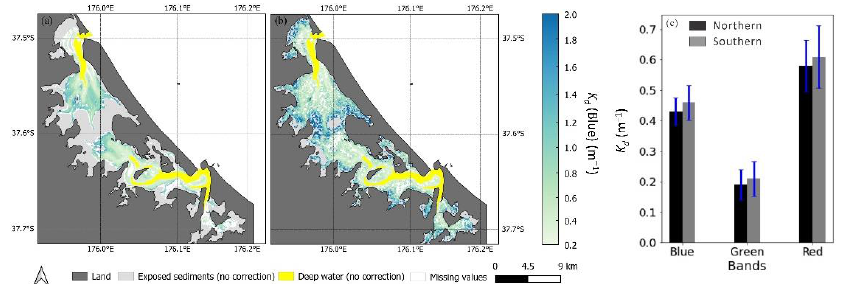
Figure 13. Estimated K d (Blue) based on the temporal method (applied monthly) ( a ) and the spatial method (with a 60-m tile size). ( b ) The images selected corresponding to Figures 8 and 10, respectively. The exact number of images used for each pixel in the temporally corrected map varied due to tidal conditions. ( c ) The averaged K d values (± standard deviation) for each visible band derived from shallow water regions after correction in the northern harbour (black) and southern (grey) harbour.